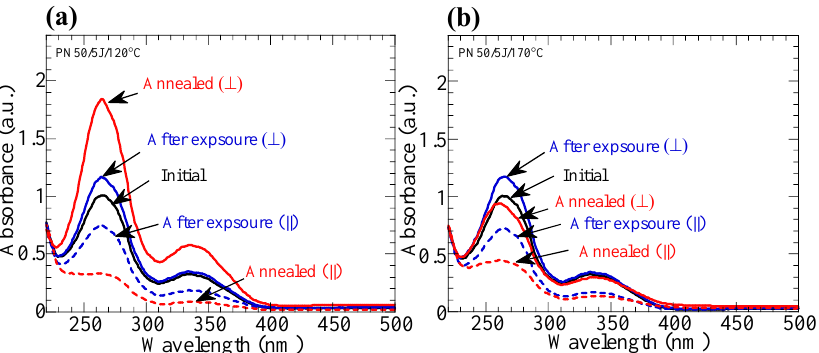
Figure 5. Changes in the thermally stimulated D values of the exposed PNx films as a function of the annealing temperature. Exposure doses are ( a ) 5 J/cm 2 , and ( b ) 100 J/cm 2 . Arrows indicate the LC temeperature range of PNx .